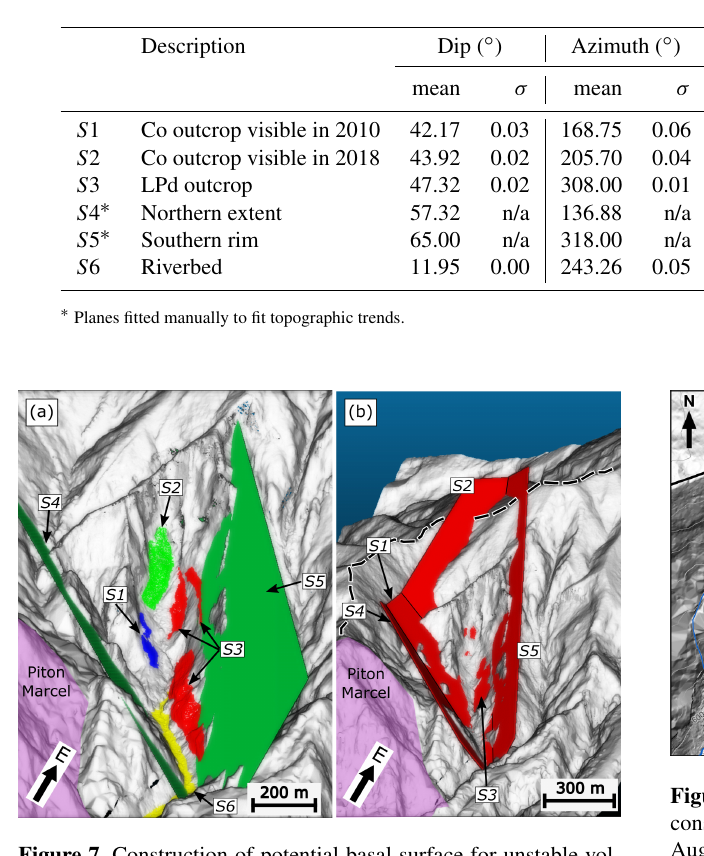
Figure 7. Construction of potential basal surface for unstable vol- ume quantification. (a) Surfaces used to define the basal surface. S 1 to S 4 are point clouds extracted from DEMs, and S 5 and S 6 are planes manually fitted to topographic trends (see Table 2). (b) Basal surface (red planes), constructed by extending and com- bining planes fitted to S 1, S 2, S 3 and S 4, as well as planes S 5 and S 6. The Piton Marcel is highlighted by the purple patch. The dashed black line is the Prêcheur destabilization structure. Table 3. Potentially unstable volumes (in m 3 ). σ is the standard deviation of volume estimation, when considering the uncertainty of basal surface reconstruction (see Appendix A).